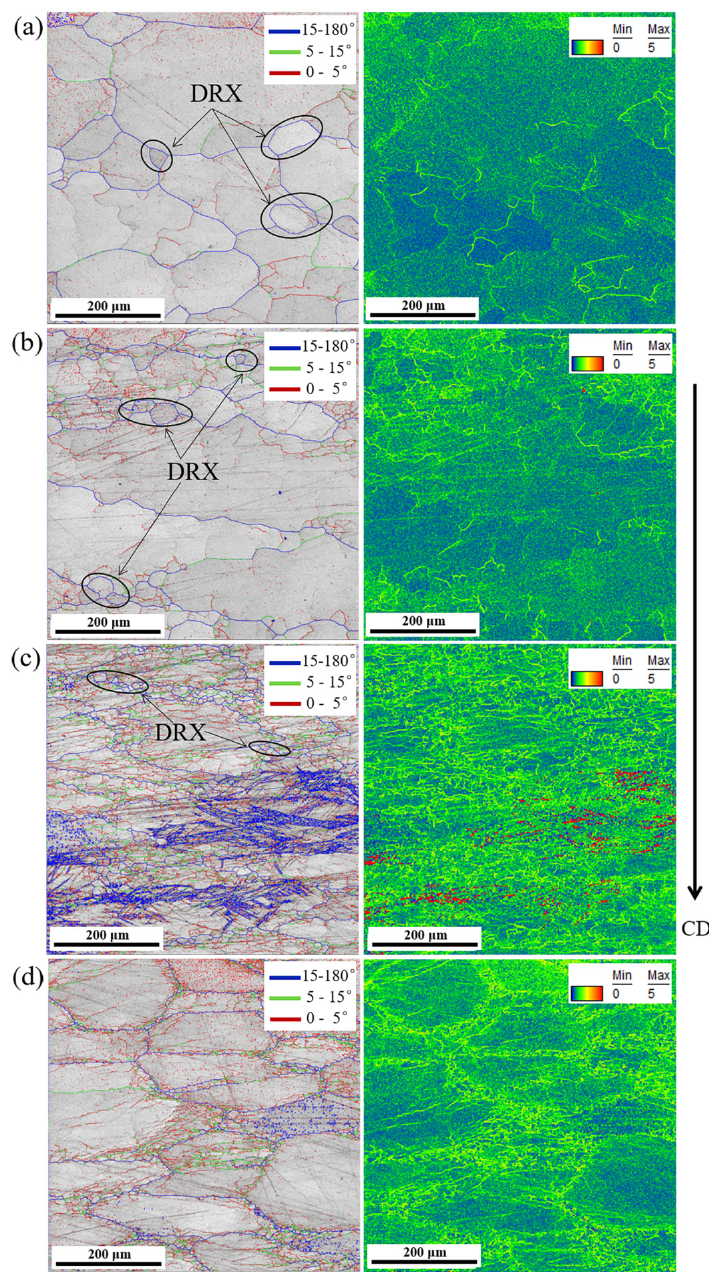
Figure 12. Grain boundary distribution and kernel average misorientation of Ti555211 samples at 1050 °C in the case of the various strain rates: ( a ) 0.005 s − 1 ; ( b ) 0.05 s − 1 ; ( c ) 0.5 s − 1 ; ( d ) 5 s − 1 .